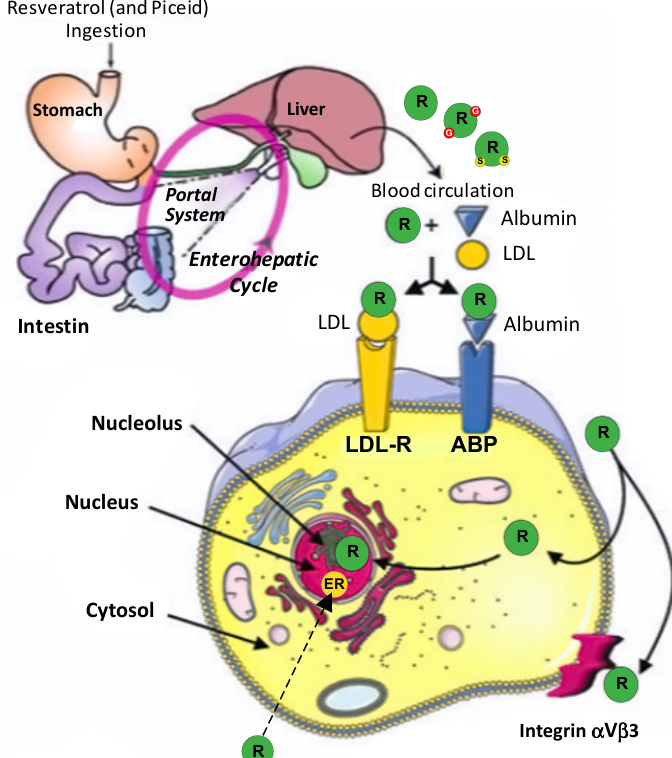
Figure 3. Metabolism of resveratrol. Adapted from Delmas et al., [47]. ER: estrogen-receptor; ABP: albumin-binding protein; LDL: low density lipoprotein; LDL-R: low density lipoprotein-receptor. resveratrol; glucurono resveratrol; sulfo resveratrol.